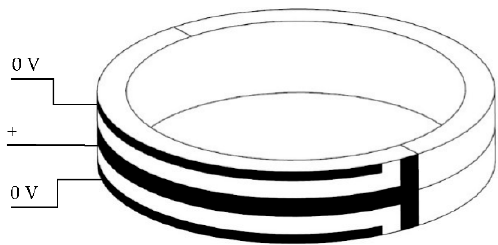
Figure 7. Partial model with two pairs of electrodes.